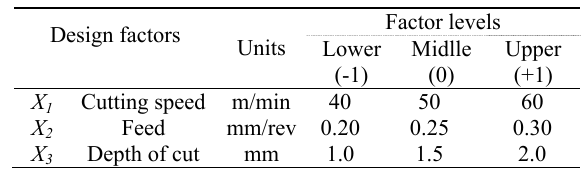
Table 11. Type of response and their